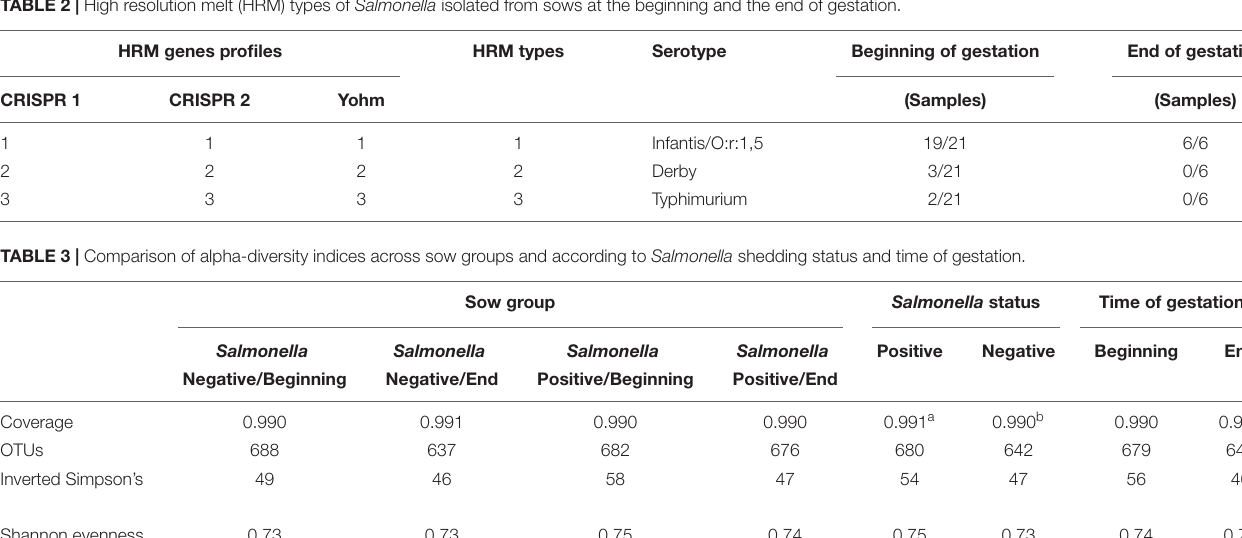
TABLE 2 | High resolution melt (HRM) types of Salmonella isolated from sows at the beginning and the end of gestation.